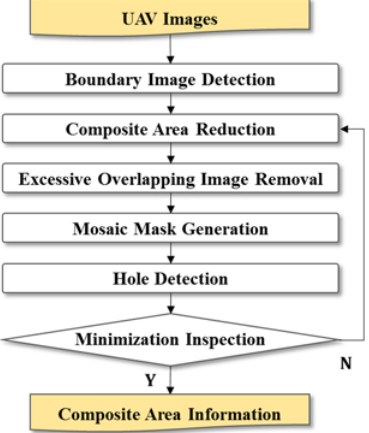
Figure 3. Work flow for composite area minimization